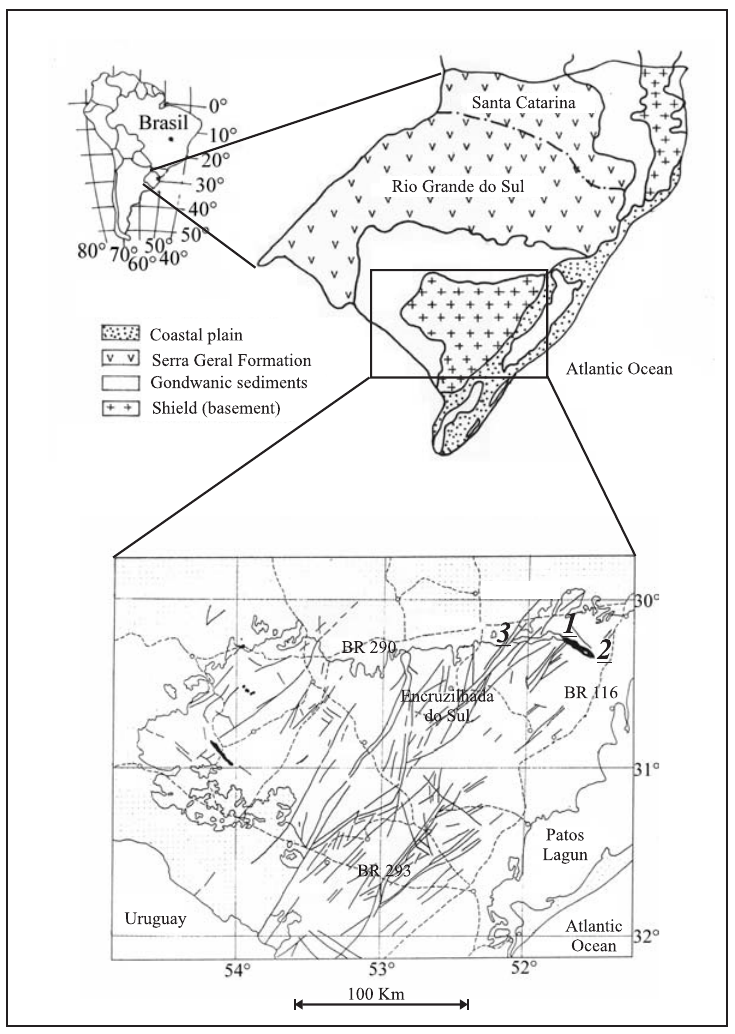
Fig. 2–LocalizationoftheFaxinal(1),